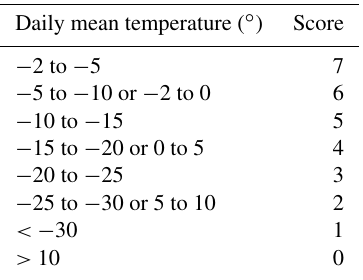
Table 2. Different daily air temperature regimes and corresponding